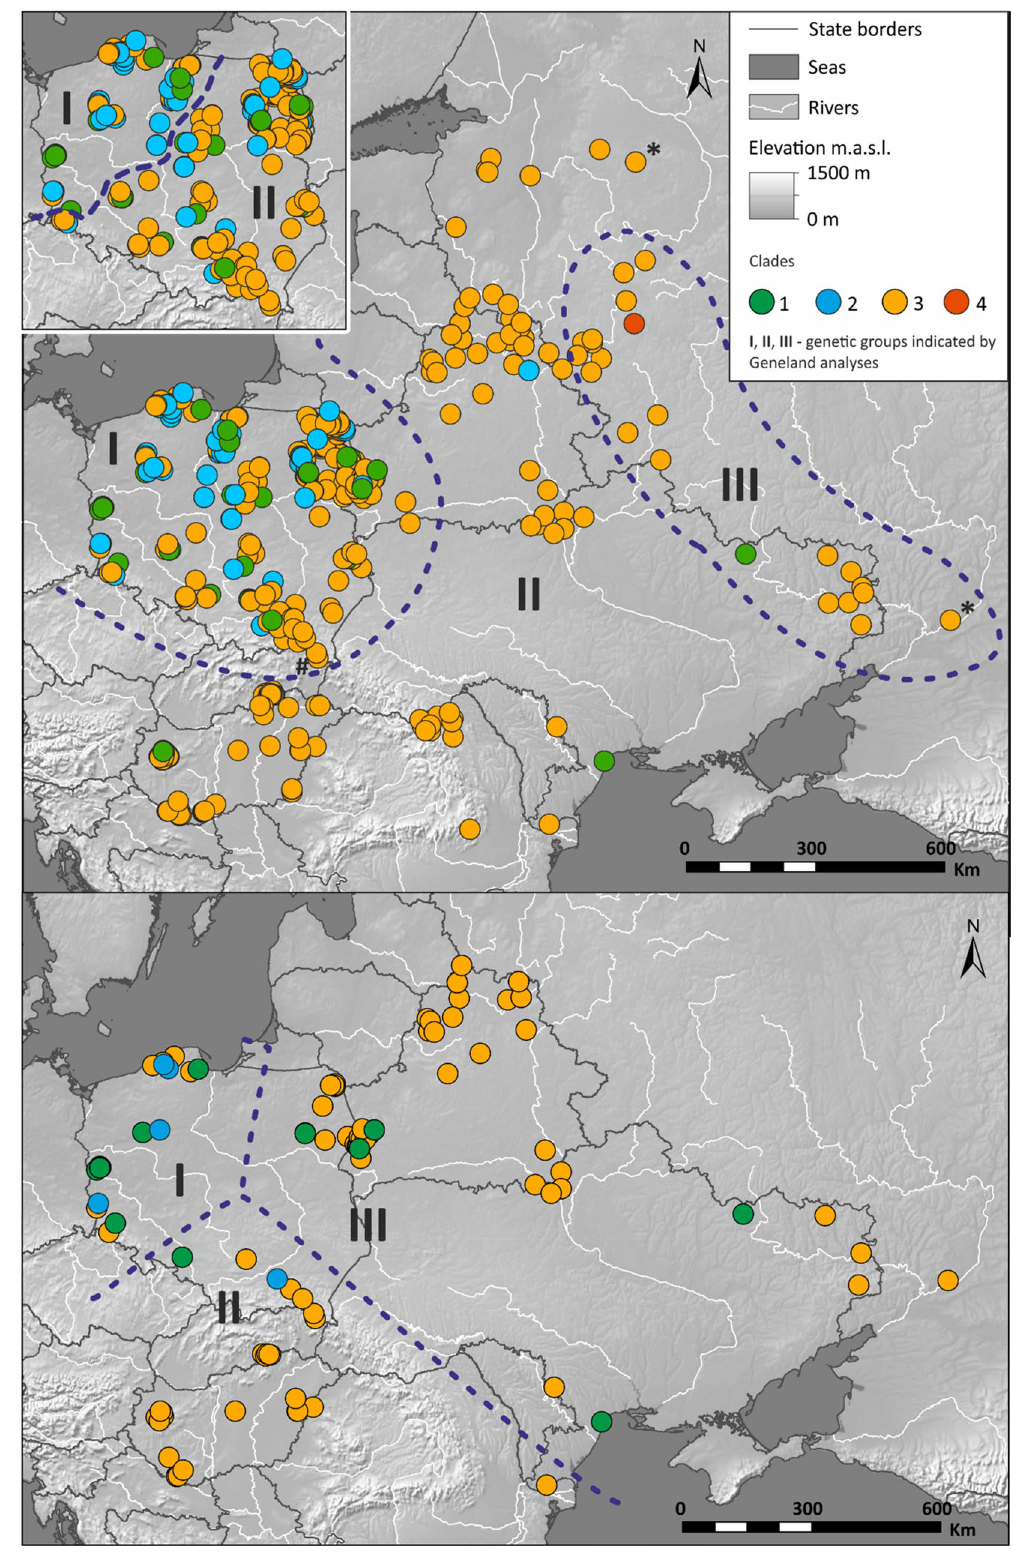
Figure 6. Distribution of three genetic populations indicated by the Geneland software based on the analyses of 548 D-loop sequences (upper panel) and 101 mitogenomes of wild boar (lower panel). Asterik means sequence assigned to one of the genetic populations with 30% probability; # means sequence assigned with 50% probability. All other sequences assigned to their populations with > 50% probability. Insert map in the upper panel: results of Geneland analysis done on D-loop sequences from Poland only. The maps were created with the ArcGIS software 10.3.1. based on source map from ESRI https:// www. esri. com/ en- us/